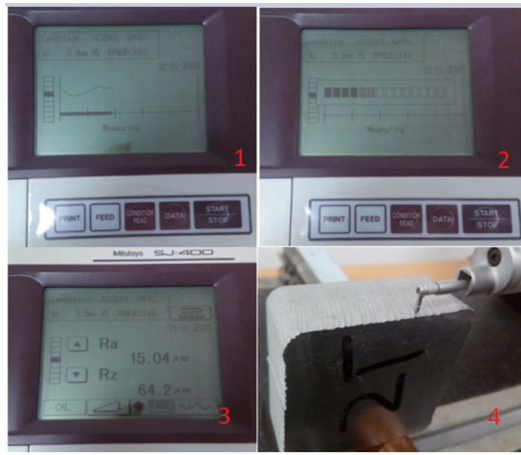
Figure 6. Contact method Mitutoyo SJ 400.